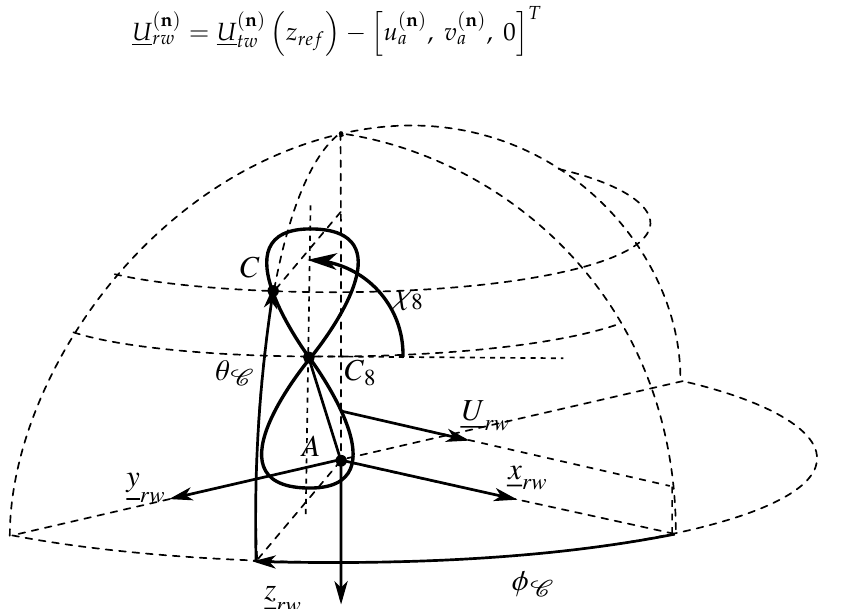
Figure 8. Lissajous trajectory